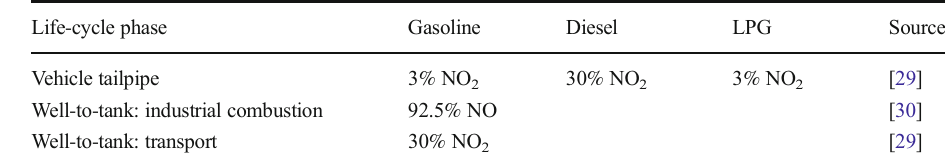
Table 5 Speciation of NOx